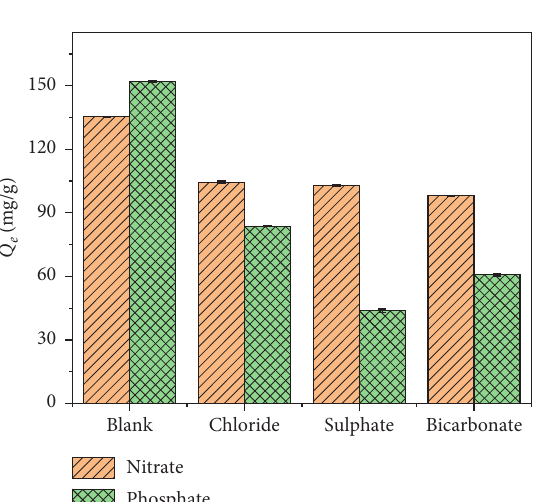
Figure 11: Effect of coexisting anions on nitrate and phosphate adsorption capacity of ferric oxide-amine